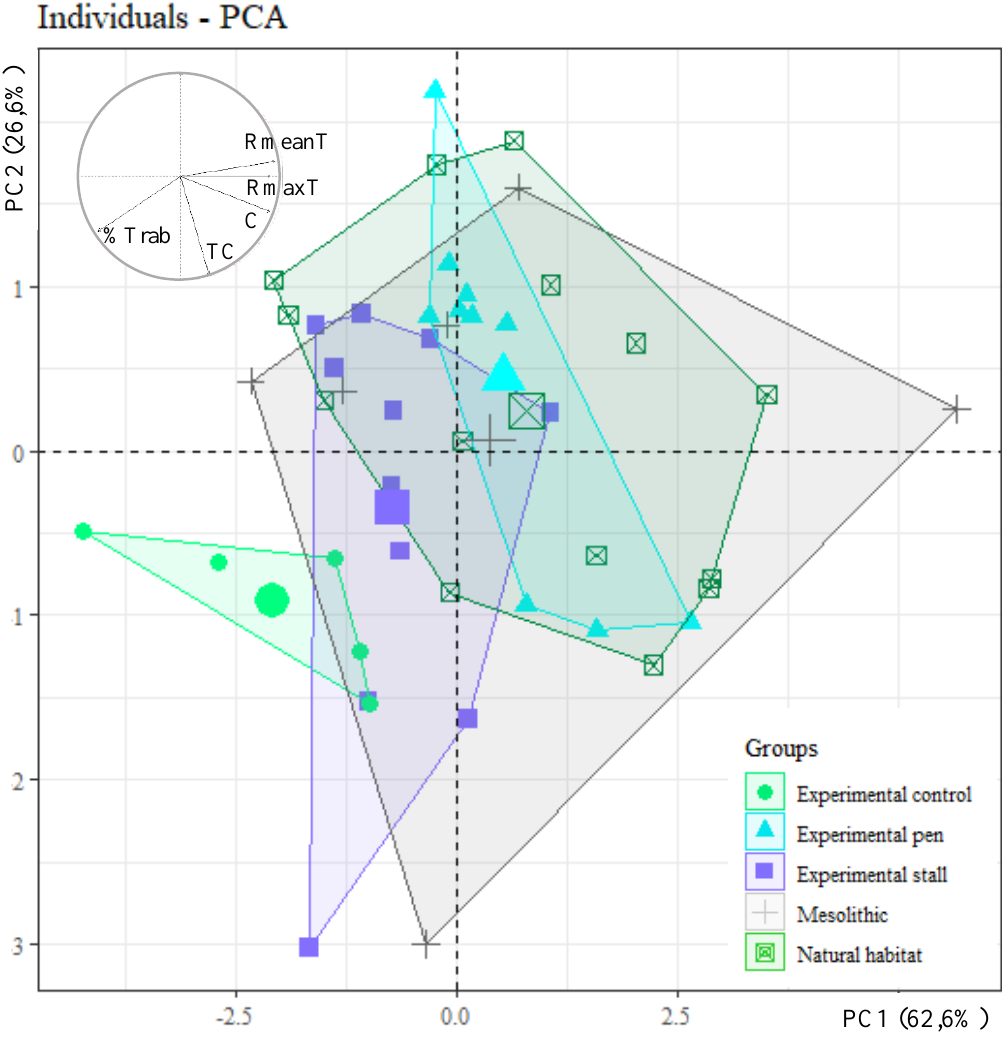
Figure 5 : Distribution of the 46 specimens and their associated context groups on the first two axes of the PCA computed on: WBV, total bone volume; RMeanT, relative mean bone thickness; RMaxT, relative maximum bone thickness; C, compactness ratio; TC, trabecular compactness ratio; %Trab, percentage of trabecular bone volume to cortical bone volume. meso, Mesolithic; nat hab, Natural